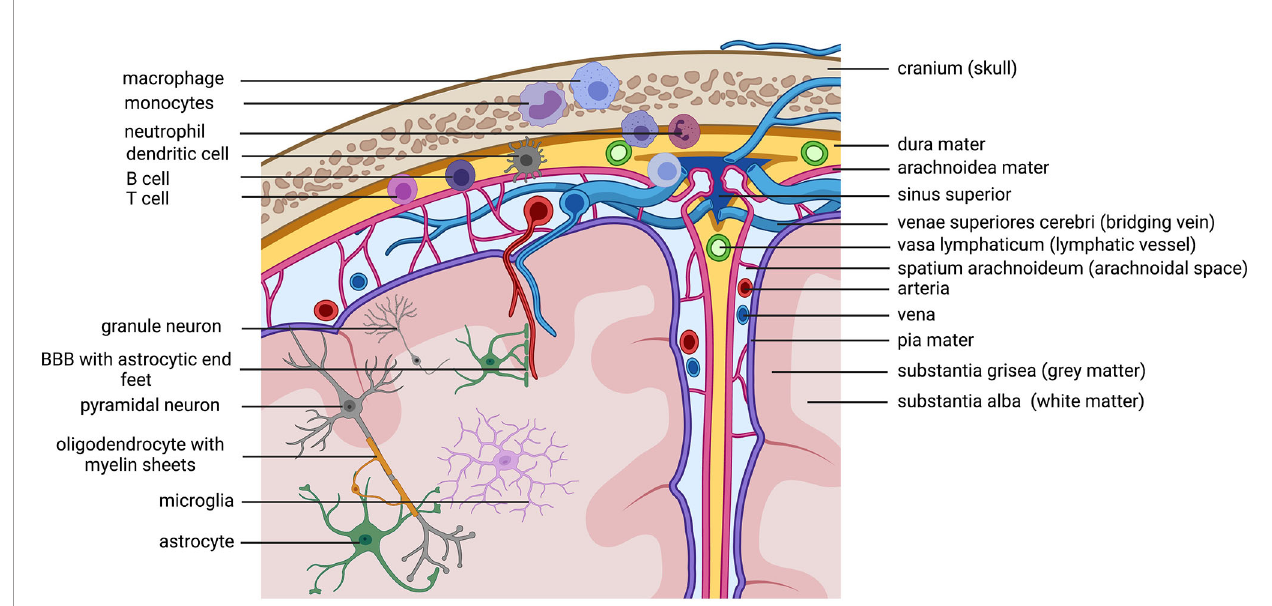
FIGURE 3 | Immune cells patrolling the CNS. Macro anatomical structures important for the brain on the right side The brain is protected by the skull and the meninges. Within the thick dura mater are lymphatic vessels that allow immune cells located within the stroma of the dura mater to drain to the cervical lymphnodes (not shown in the fi gure). The arachnoidal space is fi lled with liquor (cerebrospinal fl uid= CSF) that fl ows through the brain and contains and discards cerebral debris. Antigens within the CSF can get presented to patrolling immune cells in the dura mater close to the sinuses. Lymphocytes located in the dura are known to secrete cytokines that can reach the cerebral parenchyma and in fl uence neuronal function. Microanatomical structures /cells on theleft side.Cave! The depiction has no correct scale, the cells are depicted to big. This is only a scheme to annotate involved cell types. Because of the scale the location of cells is not perfectly correct (neuronal cell bodies are always in the grey matter, microglia are also in the grey matter). Important to note is the location of immune cells in the dura mater. Myeloid cells get directly recruited from the bone marrow of the skull. Created with